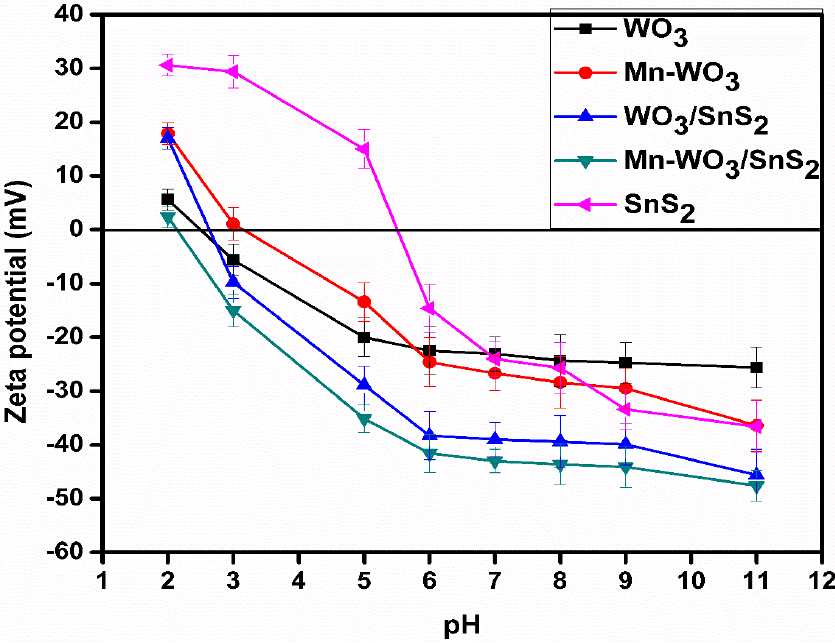
Figure 8. Surface charge of the nanoparticles.